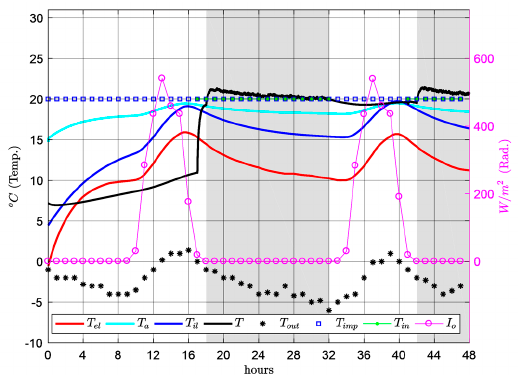
Figure 10. Case 2: Efficient energy proposal. Winter. Data: calculated temperatures: T el , T a , T il , T at a height of 1.5m, outdoor temperature T out , impulse temperature T imp , inlet temperature T in , all of them against the left y -axis, and radiation I o against the right y -axis.